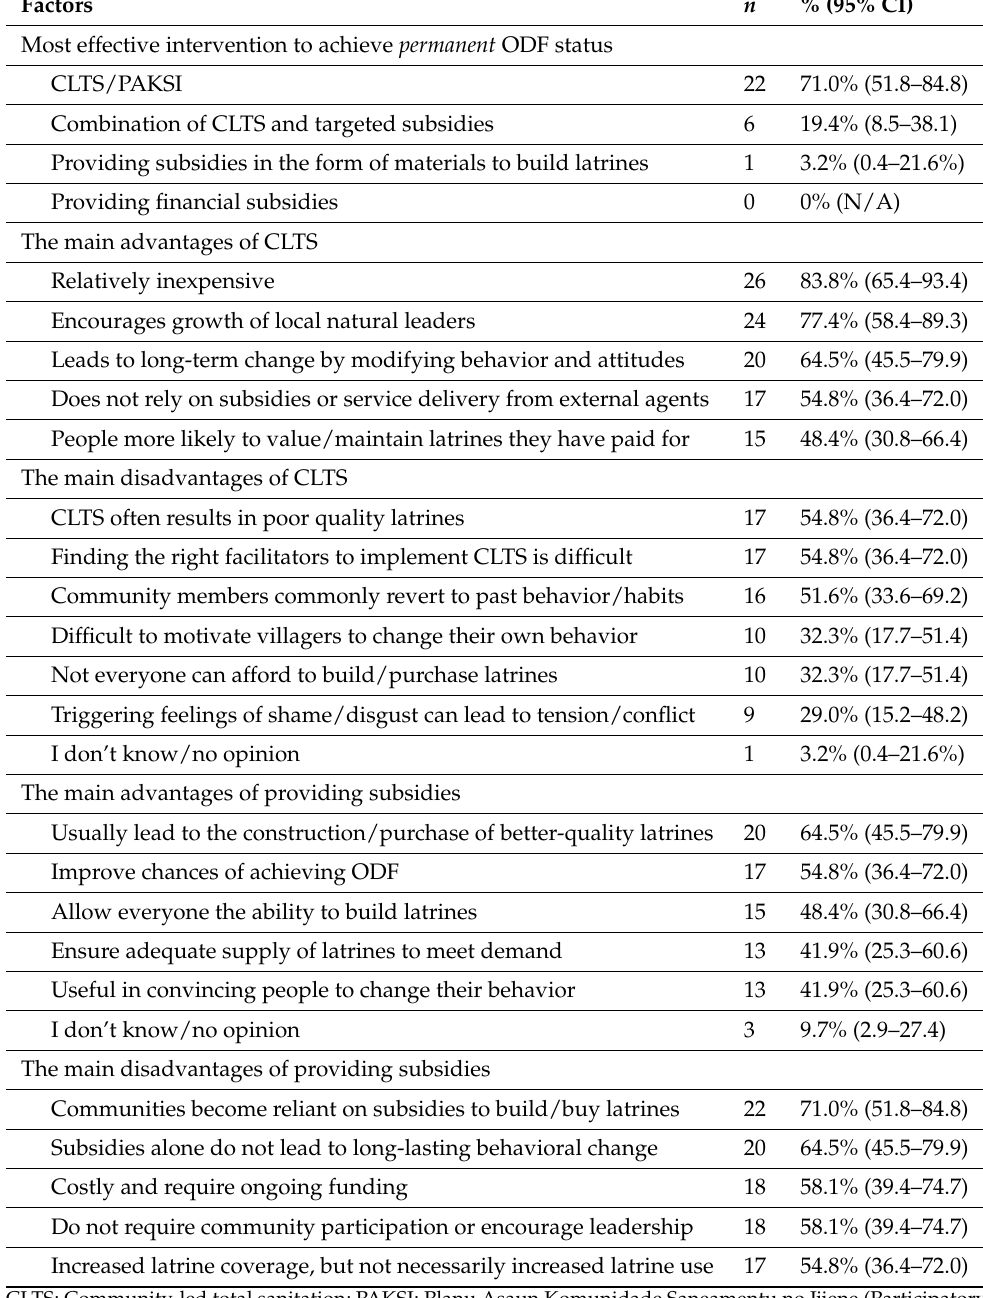
Table 3. Stakeholder views ( n = 31) on sanitation interventions used to achieve ODF status in the